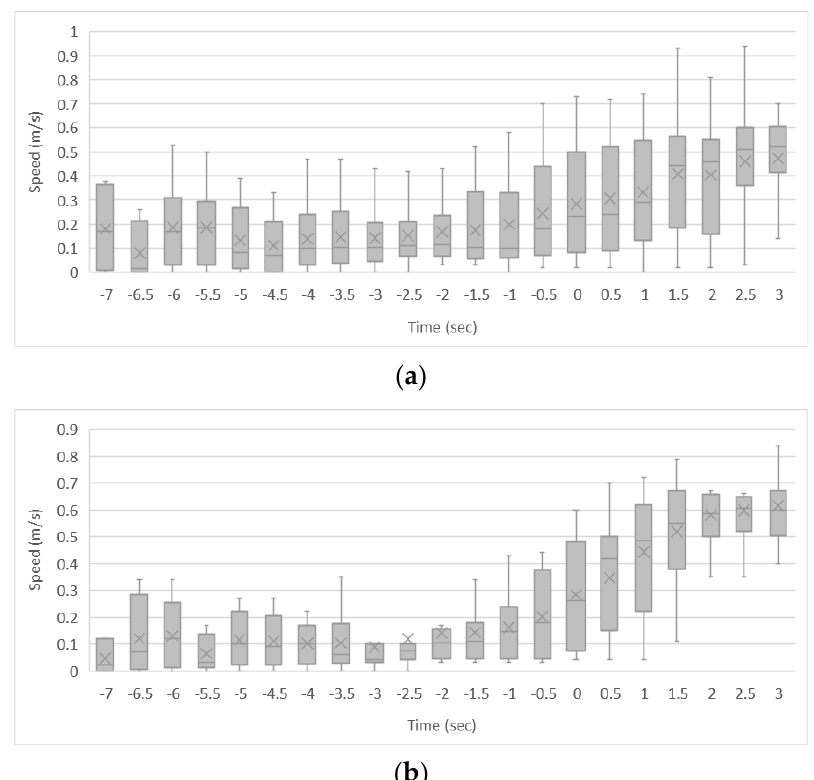
Figure 9. Pedestrian’s movement speed in Group 2a (high perceived safety) and Group 2b (low perceived safety). ( a ) Group 2a. ( b ) Group 2b.